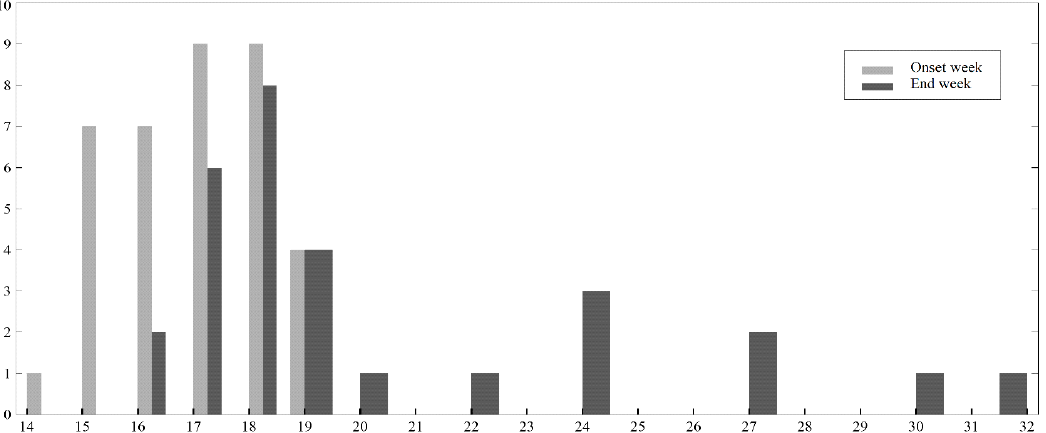
Figure 2. Preeclampsia onset week and the week of the pregnancy end by the number of cases reported. Table 2. Reported angiogenesis markers. Soluble FMS-like tyrosine kinase-1 (sFlt-1)/Placental growth factor